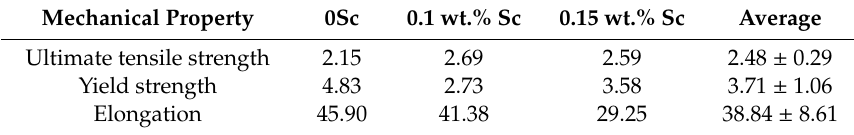
Table 7. The improvement rate of mechanical properties by applying IC-AEMS. (%).